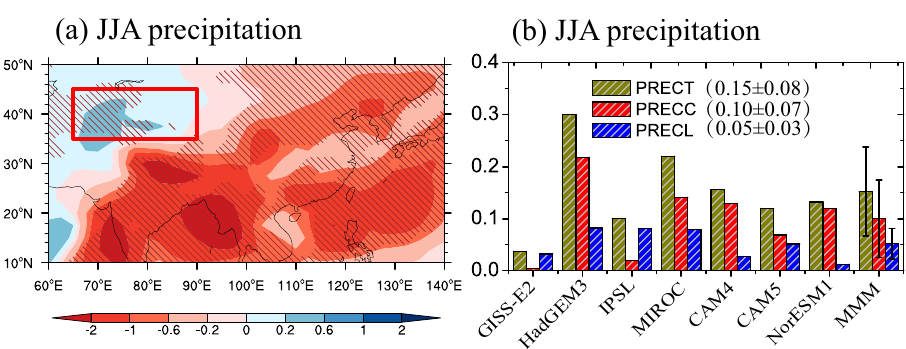
Fig. 2 Asian sulfate-induced changes in precipitation over arid Central Asia (ACA). a Geographical distribution of changes induced by increasing Asian sulfate (SULx10Asia) in JJA precipitation (mm day − 1 ) in the multi-model mean (MMM), and ( b ) for changes in JJA total precipitation (PRECT, mm day − 1 ), convective precipitation (PRECC, mm day − 1 ), and large-scale precipitation (PRECL, mm day − 1 ) averaged for the ACA domain. Slanted lines in ( a ) indicate where the MMM is more than 1 standard deviation away from 0 and error bars of MMM in ( b ) represent the standard deviation among the